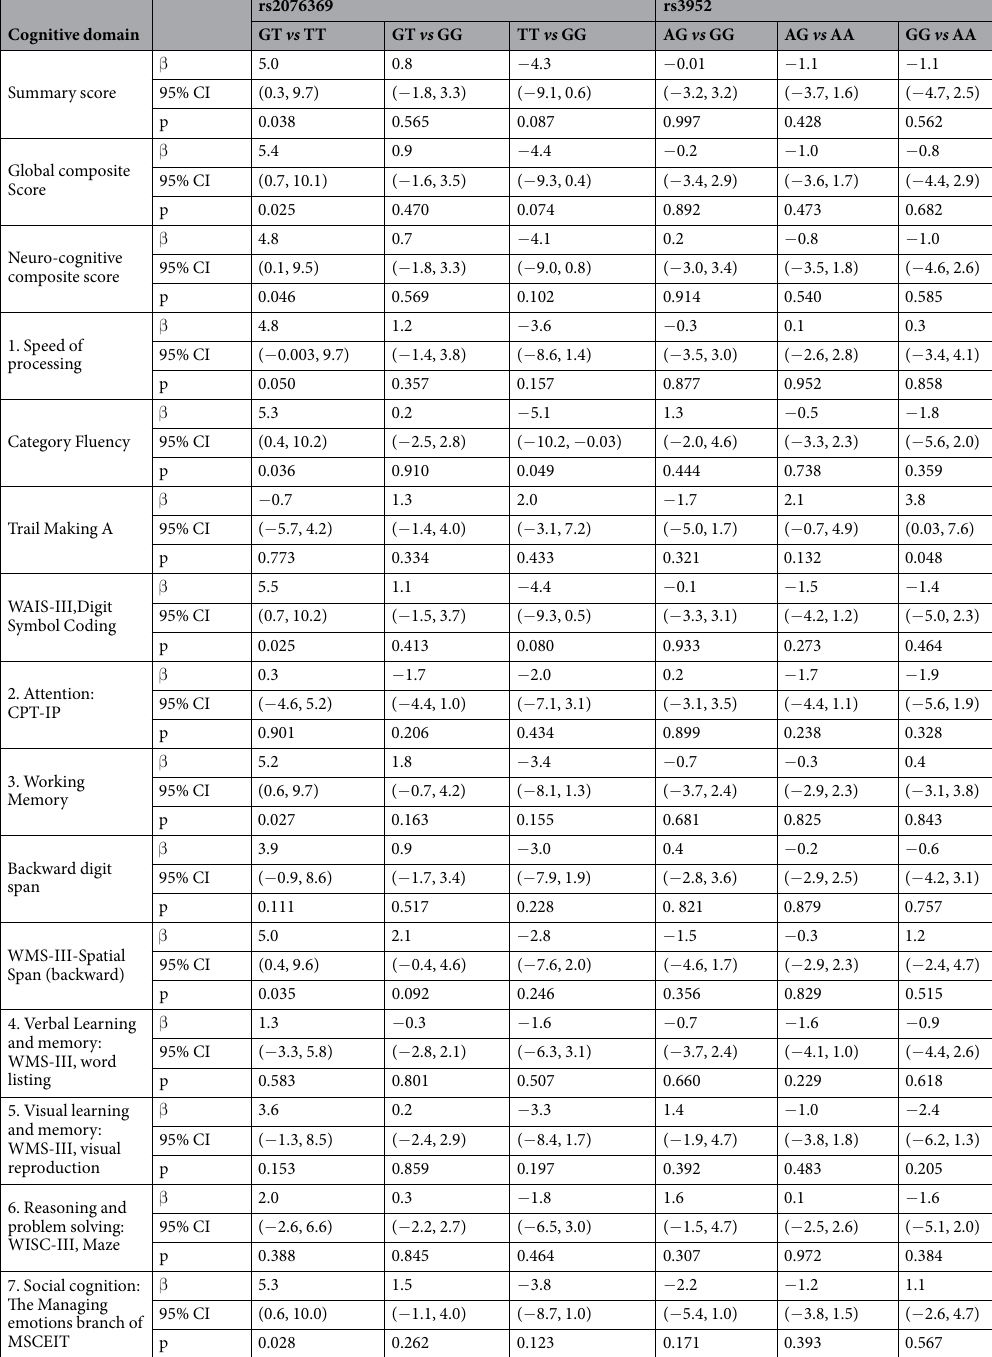
Table 5. Multiple regression model analysis of the effects of genetic polymorphism on cognitive function in schizophrenic patients by general linear model. All data were standardized to T scores. β = Estimated Coefficient, 95% CI = 95% confidence interval. P-value was based on the multiple regression model analysis of cognitive function between genetic groups by General linear model (GLM). We ran our model to fit both polymorphisms in the same model to correct the influence by the other polymorphism; in addition, we also included age, gender and years of education in the